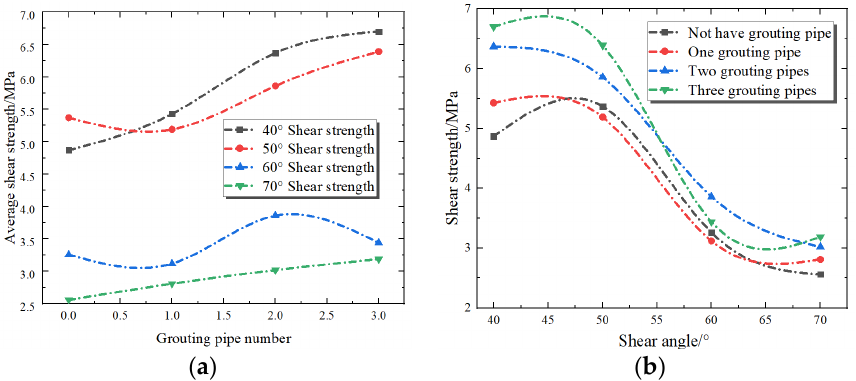
Figure 9. Relationship between different grouting pipes, shear angle, and shear strength: ( a ) different quantities of grouting pipe; ( b ) different shearing angles.